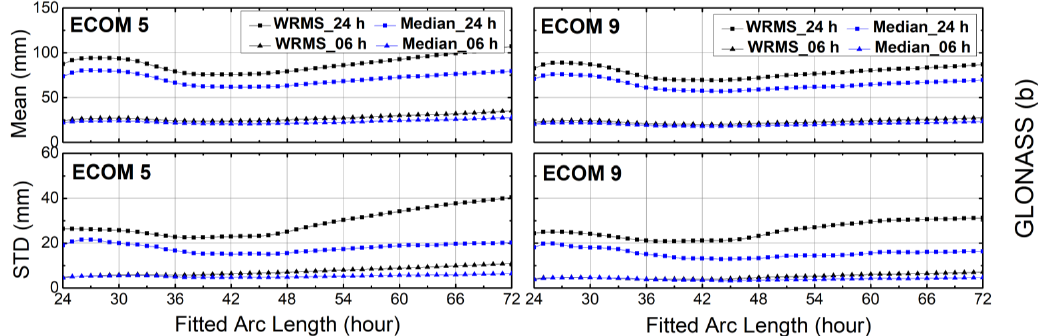
Figure 5. The means and standard deviations (STDs) of weighted root-mean-square (WRMS) and median residuals for orbit differences between predicted orbits and precise ephemerides after Helmert frame transformation over the first 6 h and full 24 h intervals for GLONASS. Results for reduced Empirical Center for Orbit Determination in Europe Orbit Model (ECOM-5) are shown on the left and for nine-parameter (ECOM-9) on the right planes.